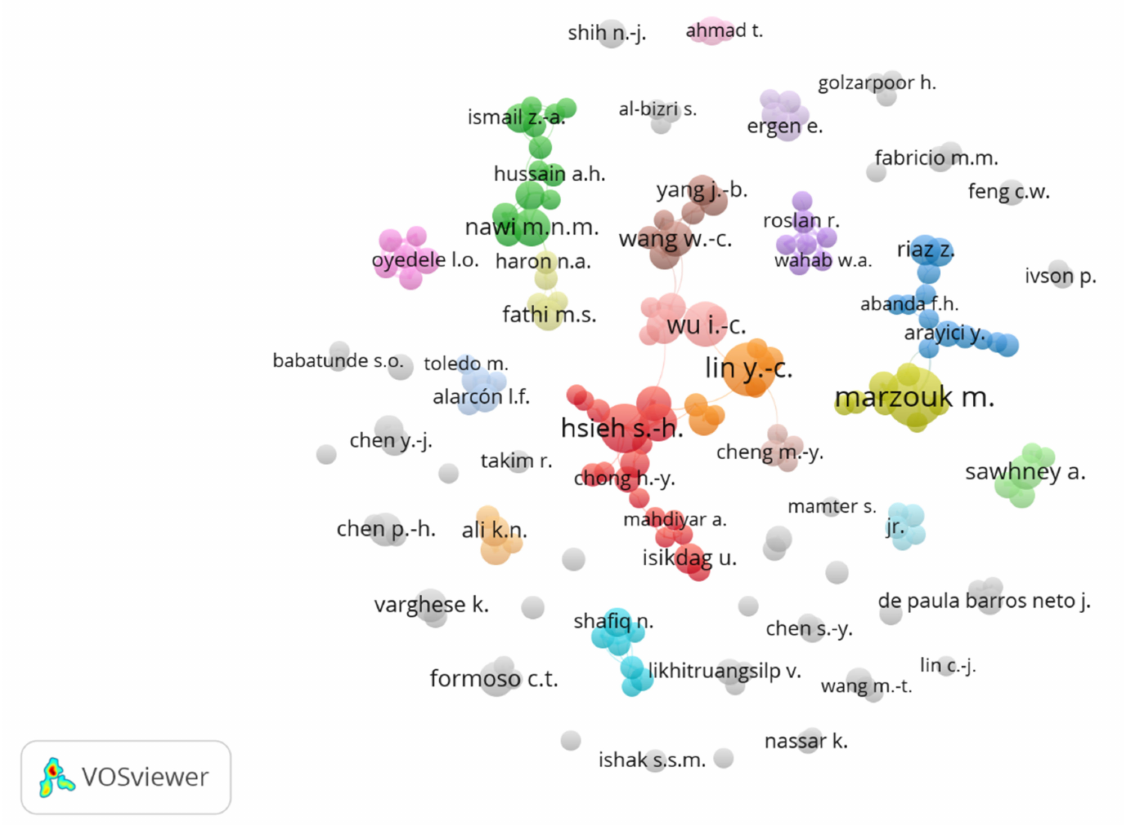
Figure 7. Co-authorship network.